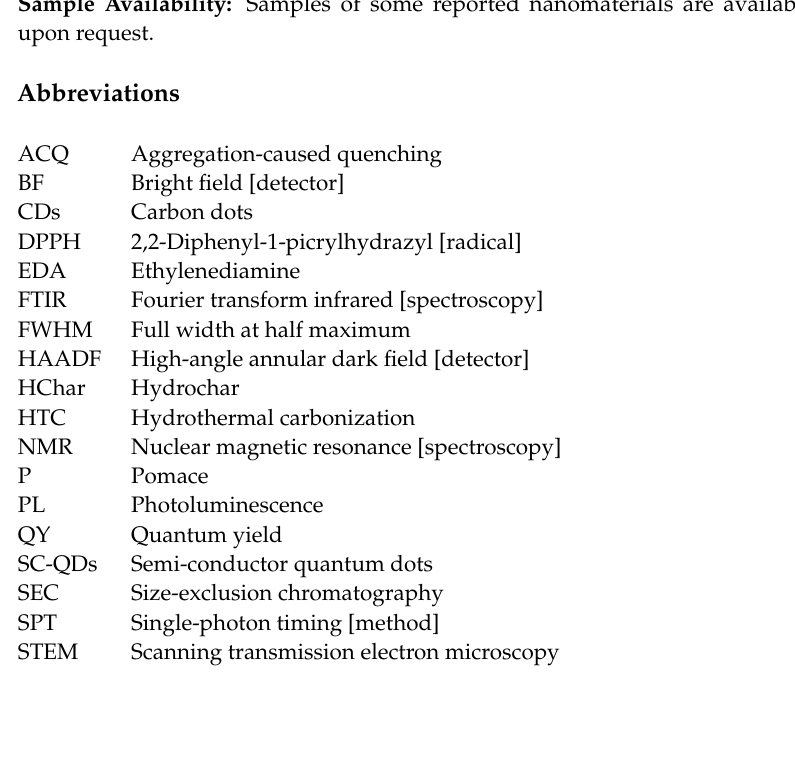
Table S4: Raman analysis; Tables S5 and S6 and Figure S7: XPS analysis; Figure S8: UV-Vis analysis; Tables S7 and S8: Quantum yields and lifetimes; Figure S9: Emission dependence on excitation wavelength; Figure S10: Quenching of emission by an external quencher; Figure S11: Photostability; Figure S12: Emission vs. pH; Table S9: Lifetime vs. concentration; Figure S13: Effect of WP-CDs on resazurin